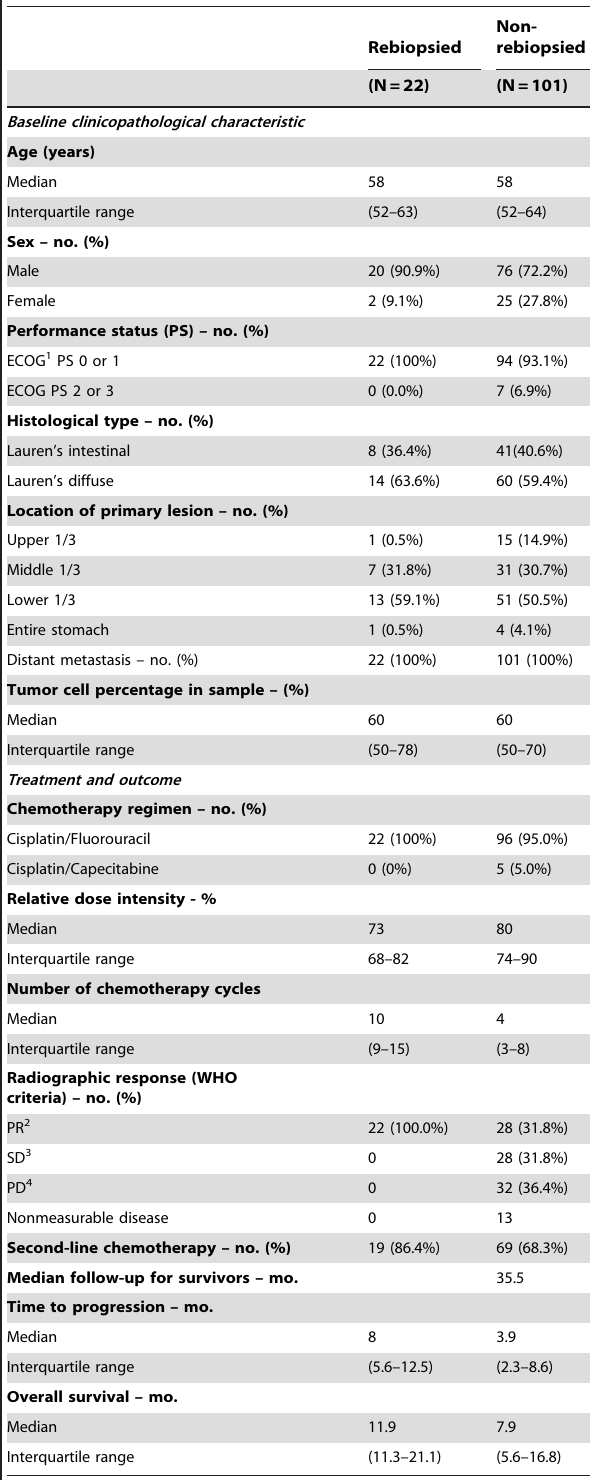
Table 1. Clinicopathological Characteristics of Patient Subgroups Used for This